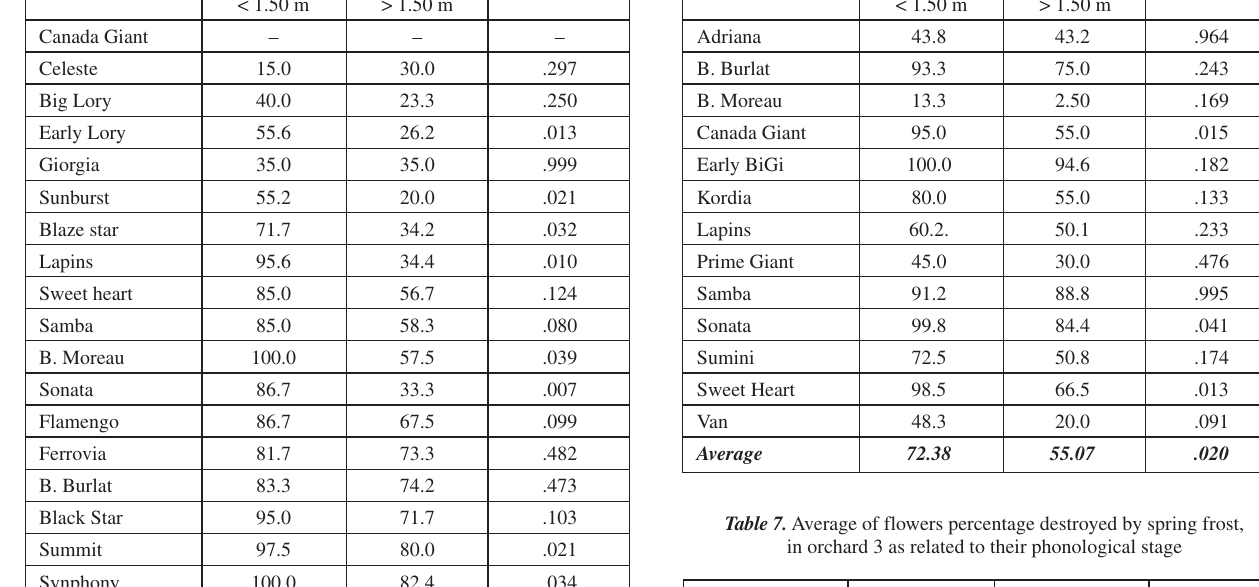
Table 4. Average of flowers percentage destroyed by spring frost, Table 6. Average of flowers percentage destroyed by spring frost, in orchard 1 as related to flowers height from the ground in orchard 3 as related to flowers height from the ground Height from the ground Height from the ground Varieties significance (p) Varieties < 1.50 m > 1.50 m Canada Giant